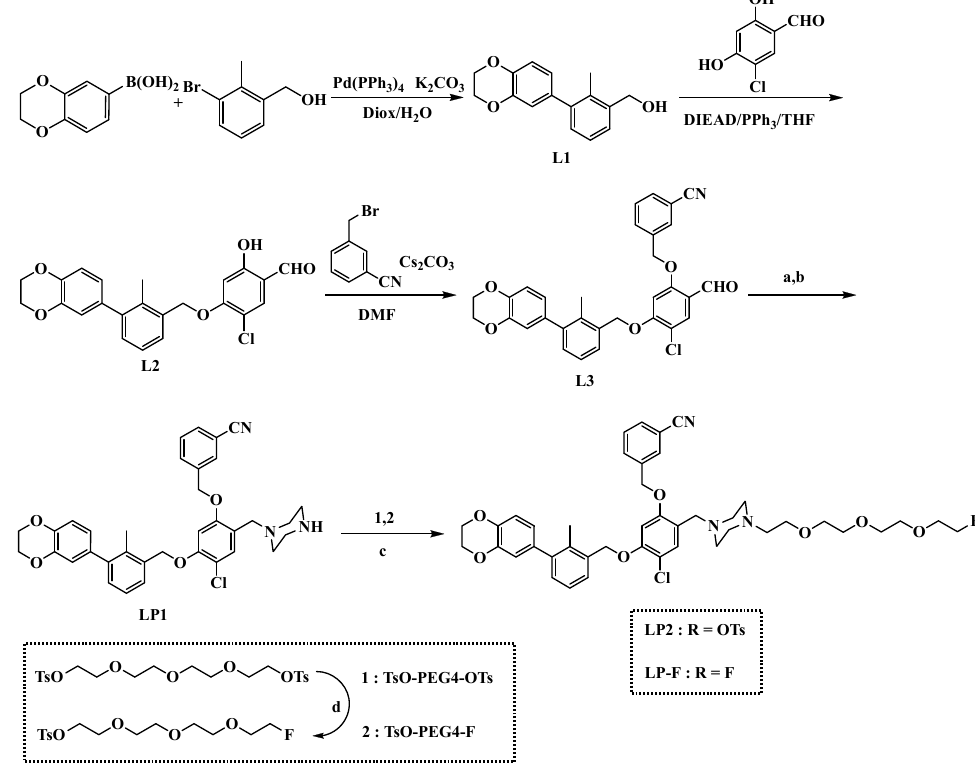
Scheme 2. Synthesis of the precursor compound LP2 and the non-radioactive probe LP-F . Reaction conditions: ( a ) piperazine, AcOH, DMF, 45 ◦ C, 4.5 h; ( b ) NaBH 3 CN, 24 h; ( c )